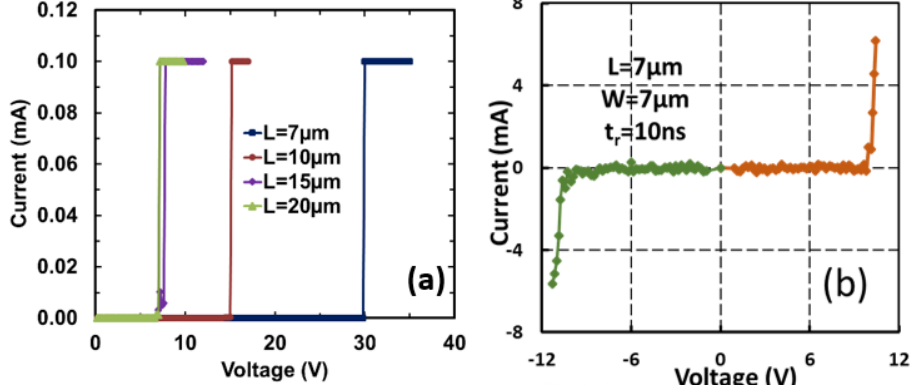
Figure 19. Measured conduction characteristics for gNEMS prototypes: ( a ) DC sweeping test showing static switching effect with turn-on voltage affected by the graphene membrane length (7.0, 7.6, 15, 29.8 V), and ( b ) TLP test showing dual-directional transient ESD discharging I-V behavior